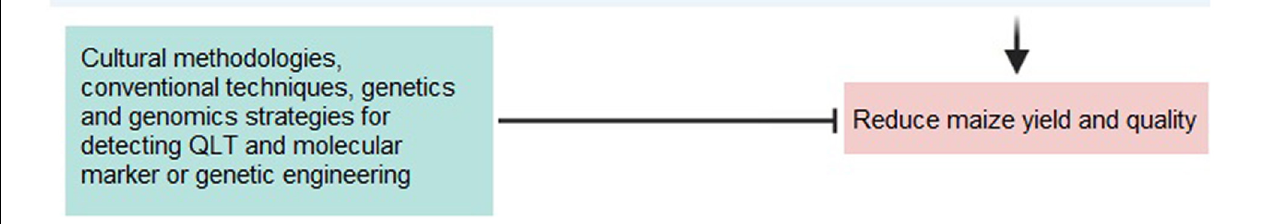
FIGURE 2 | Morphological and physiological characteristics of maize under heat stress. This figure was made using BioRender.